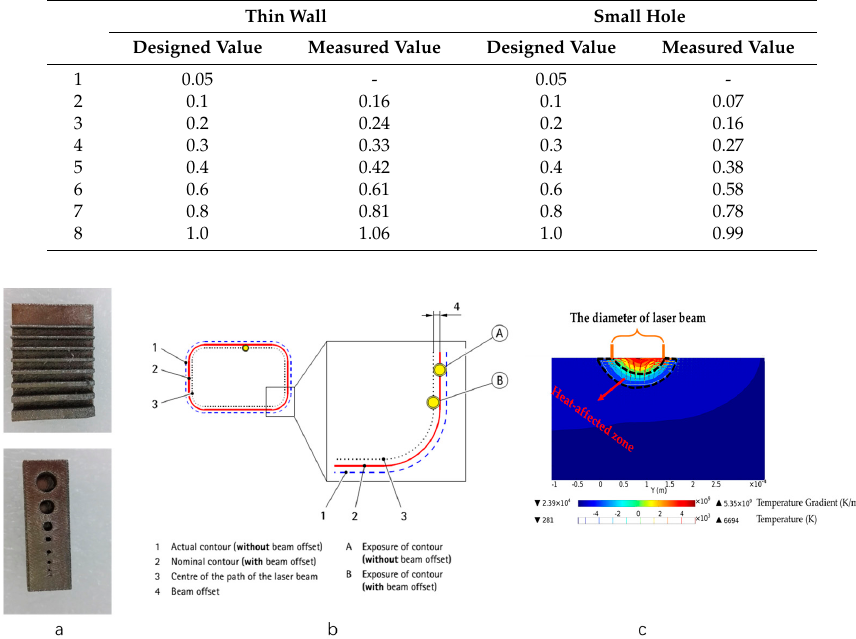
Table 1. Measurement parameters of the thin walls and the small holes.